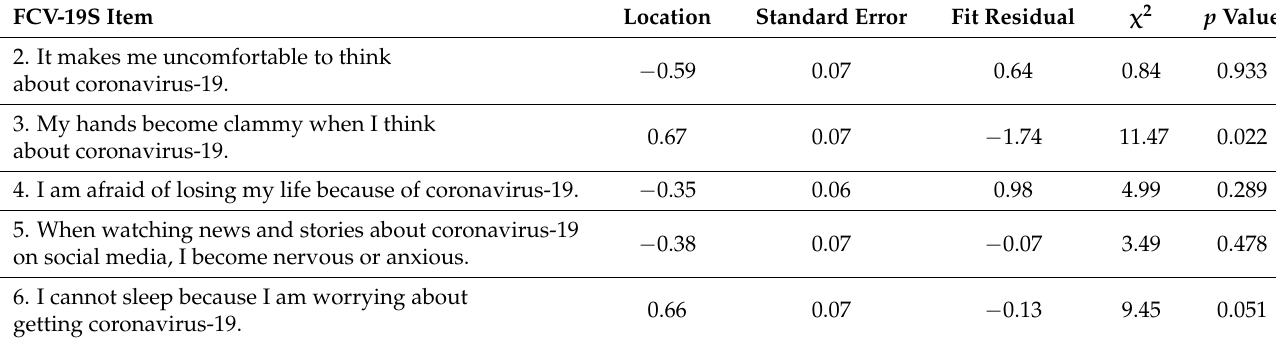
Table 5. Individual item fit of the FCV-19S after removing items 1 and 7. FCV-19S Item